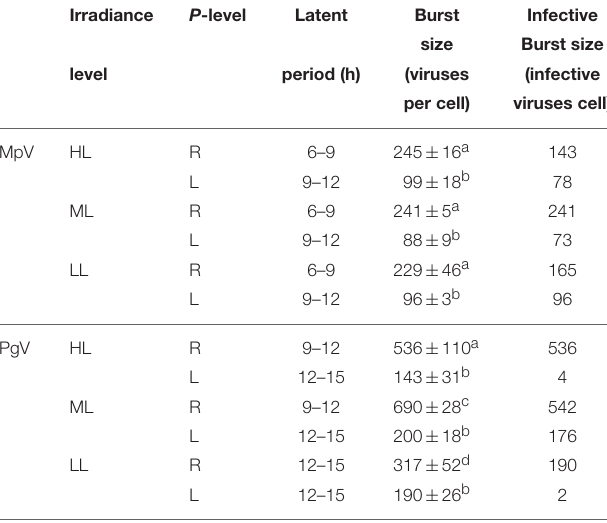
TABLE 2 | Latent periods and burst sizes of M. pusilla virus (MpV) and P. globosa virus (PgV) under P replete (R) and P limited (L)